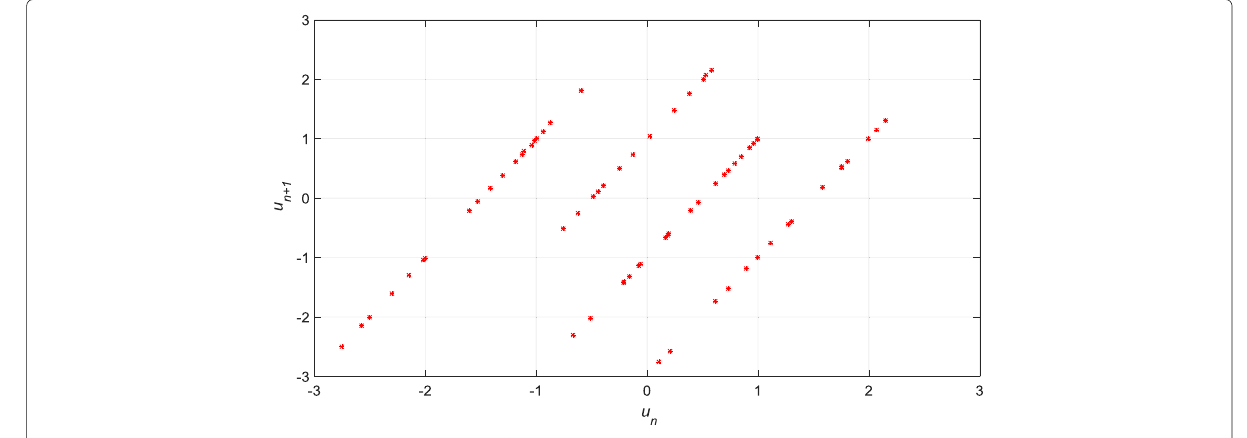
Fig. 9 A chaotic map of the proposed system with β = 10 3 ln ( 2 )